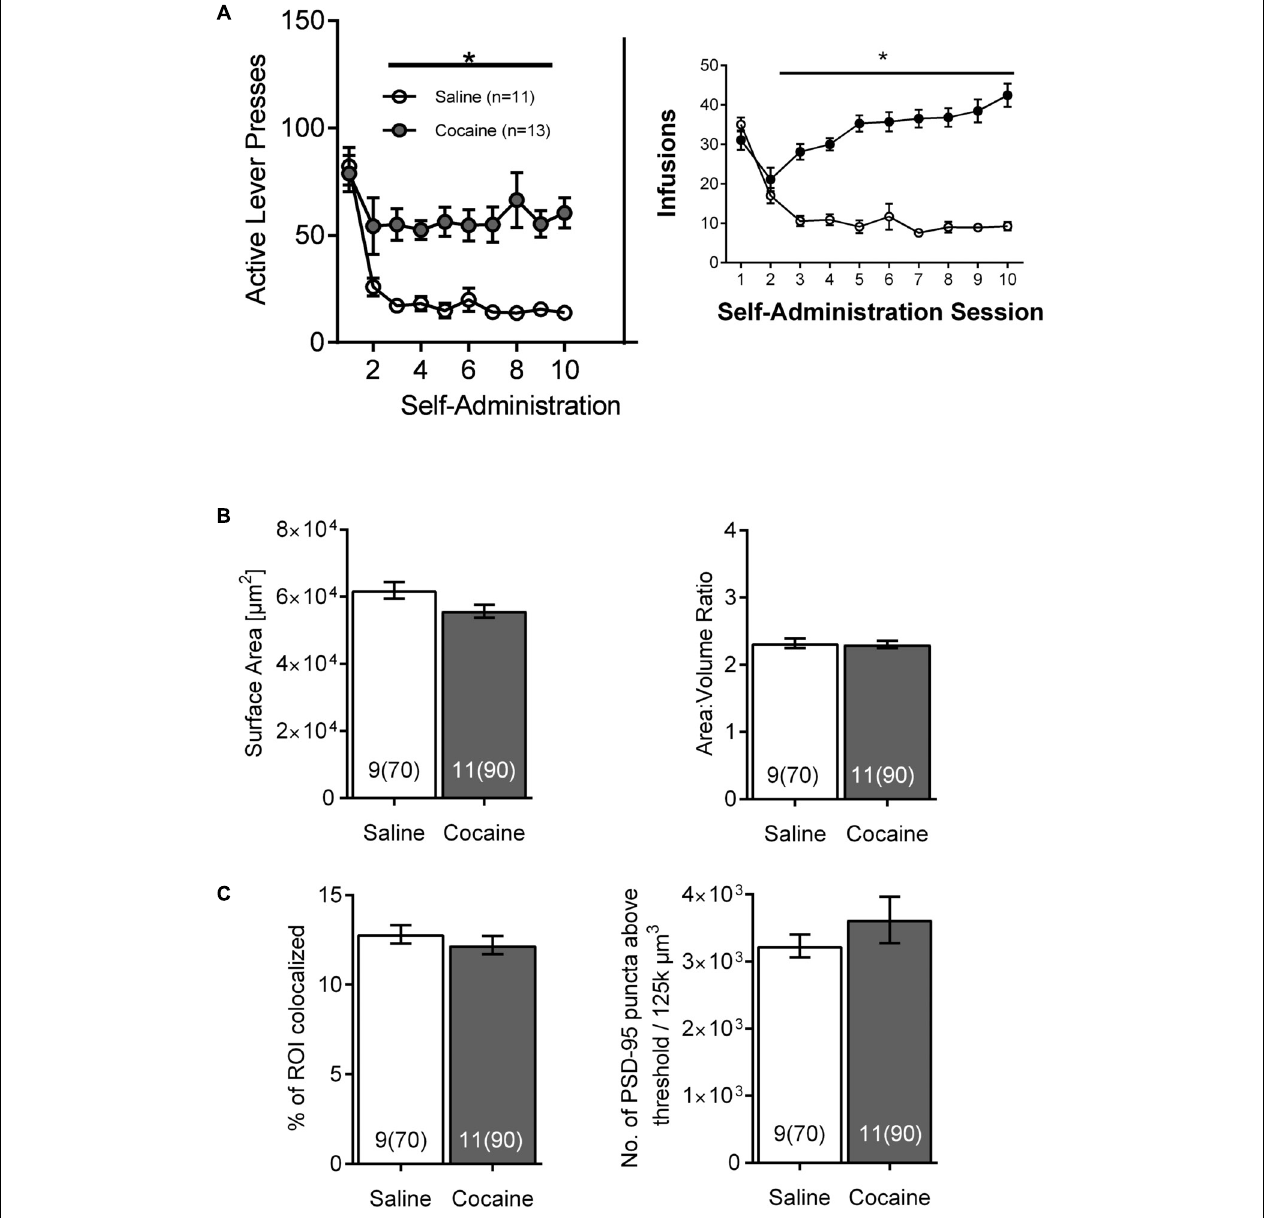
FIGURE 4 | The effects of cocaine self-administration on NAc astrocytes is not observed 24 h following the last self-administration session. (A) Active lever presses and cocaine infusions by session across self-administration (10 days) ( ∗ p < 0.05 by two-way ANOVA). (B) No significant differences were observed in surface area (left) or surface area:volume ratio (right) in NAc astrocytes following cocaine versus saline self-administration. Bar insert: number of animals and number of cells (in parentheses). (C) No significant differences were observed following self-administration in NAc astrocyte:PSD-95 colocalization (left) or in the PSD-95 expression (right). Bar insert: number of animals and number of cells (in